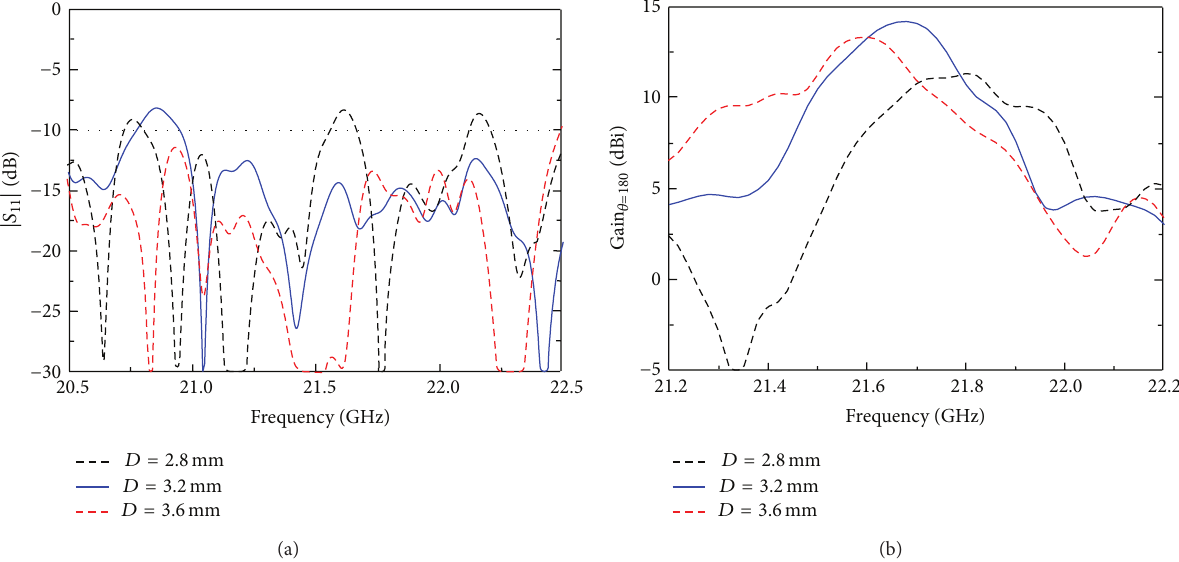
Figure 8: Effect of the hole diameter, 𝐷 , on antenna characteristics with respect to (a) the reflection coefficient and (b) boresight